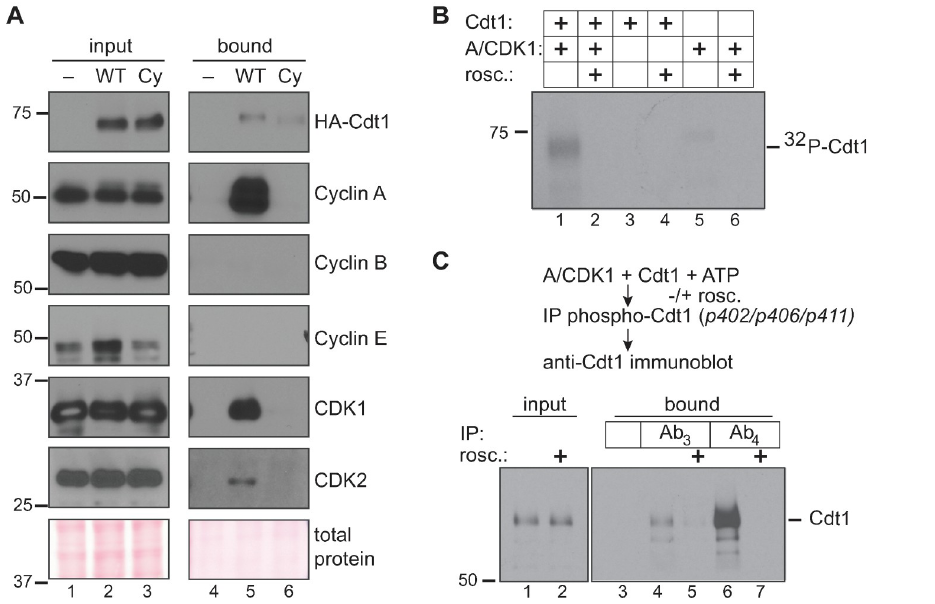
Fig 4. Cyclin A/CDK1 phosphorylates Cdt1 linker sites. A) HEK 293T cells were transfected with control plasmid or plasmid producing His-tagged Cdt1-WT or a Cdt1-variant that cannot bind CDKs (Cdt1-Cy) then synchronized with nocodazole and harvested by mitotic shake off. Cdt1 was retrieved on nickel-agarose, and the indicated endogenous proteins were detected in whole cell lysates (lanes 1–3) and bound fractions (lanes 4–6) by immunoblotting. The result is representative of at least two independent experiments. B ) Recombinant partially-purified Cdt1 was incubated with purified Cyclin A/CDK1 in the presence of 32 P- γ -ATP in kinase buffer for one hour at 30˚C. Control reactions contained Cdt1 only, kinase only, or were complete reactions in the presence of 20 μ M roscovitine (CDK inhibitor) as indicated. Reactions were separated by SDS-PAGE followed by autoradiography. C) Recombinant Cdt1 was